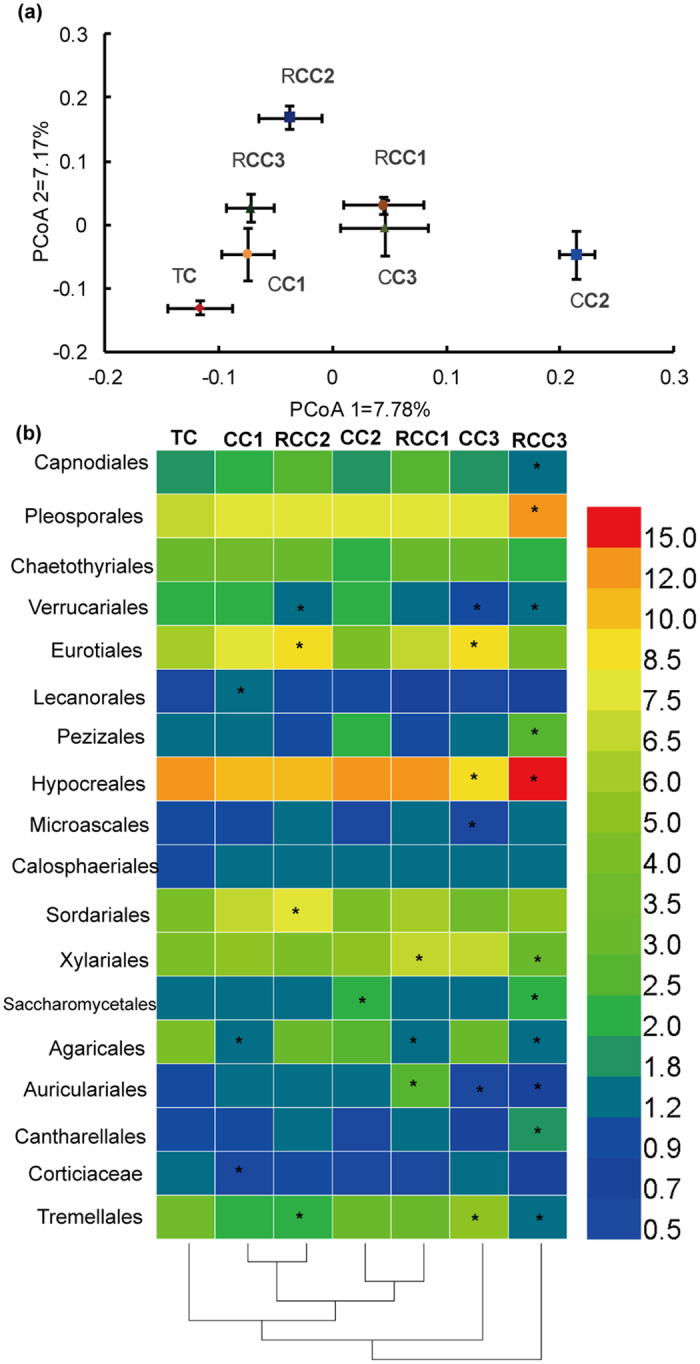
Changes in fungal communities in notoginseng cropping and traditional cropping soils.(a) PCoA ordination plots show the relatedness of samples that were separated using Unweighted UniFrac distances of classified 18S rRNA gene sequences. (b) Heat map shows major fungal orders with average relative abundance >0.5% in all samples. Clustering on the x-axis is based on fungal composition of the samples. Data are mean values of n = 3; asterisks denote significant differences between the traditional cropping and notoginseng cultivation in the relative abundance of soil fungal taxa at P < 0.05.